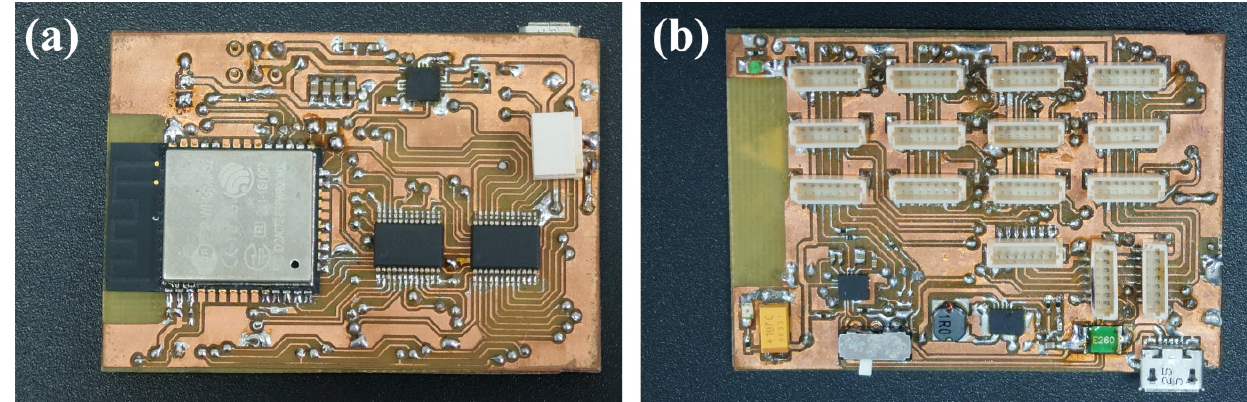
Figure 4. View of WSS: ( a ) from the Wi-Fi module side, ( b ) from the connectors side.